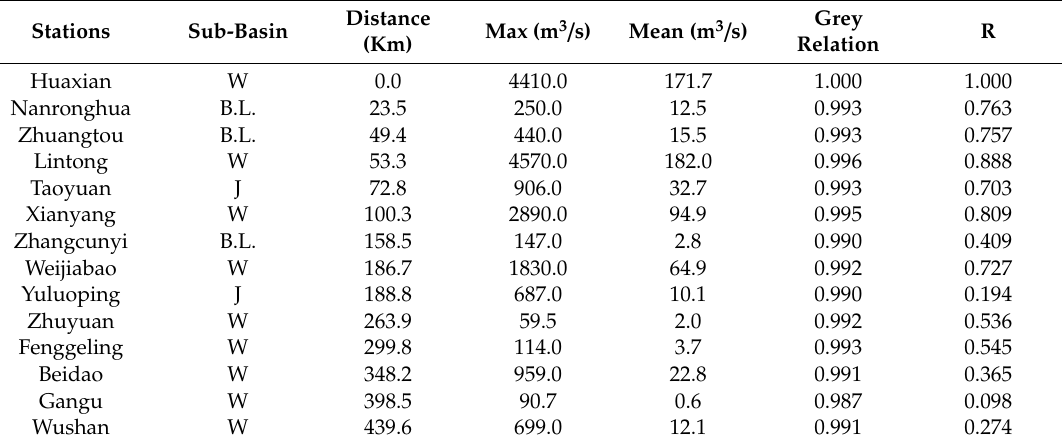
Table 1. A summary of the runo ff data at hydrological stations.